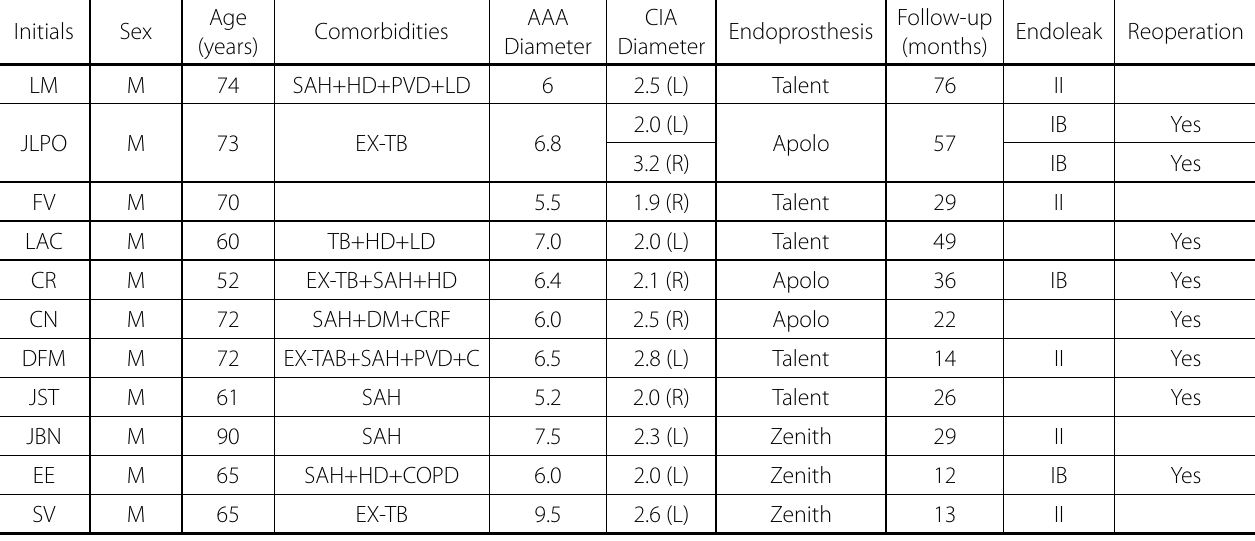
Table 1. Characteristics of patients who had endoleak and/or need to be re-operated. Initials